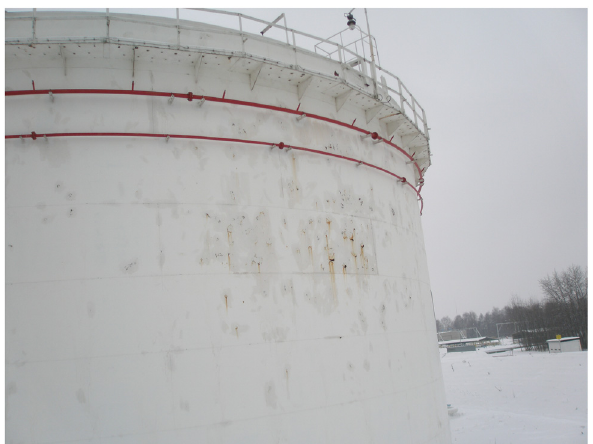
Figure 2: General view of the tested tank number 1 with the sprinkler system installed at the top.